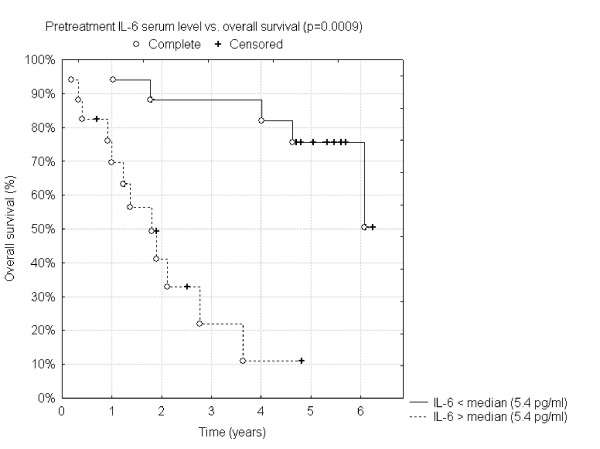
Kaplan-Meier curve overall survival analysis. There was a highly significant difference in overall survival between patients with pretreatment IL-6 serum levels above and below the median (11.9 vs. 74.9% at 5 years, p = 0.0009)